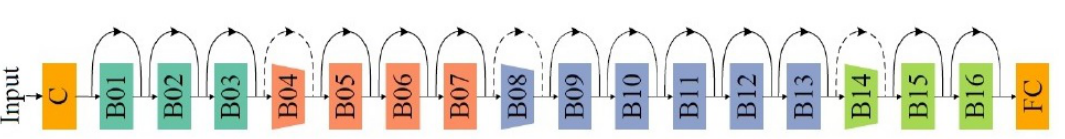
Figure 7. The structure of Resnet101 [29].